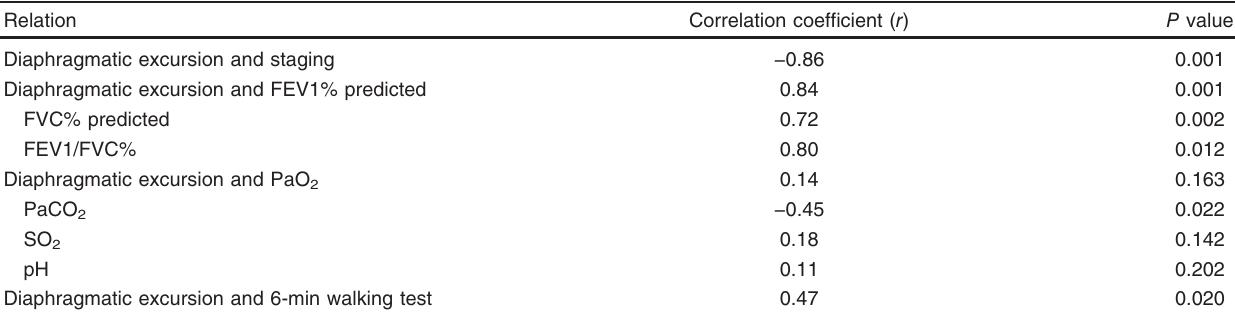
Table 6 Correlation between diaphragmatic excursion and the studied variables in patients with chronic obstructive pulmonary disease